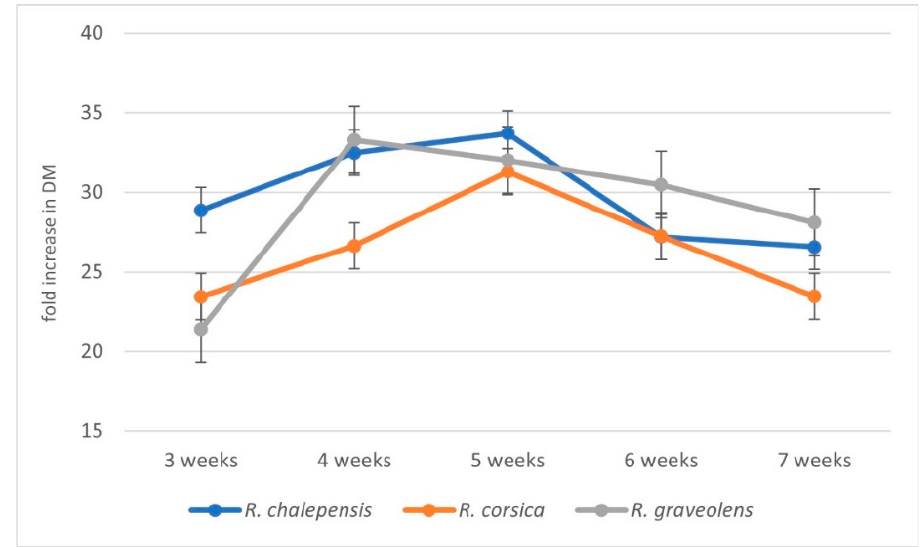
Figure 1. Average ( n = 3, ±SD) biomass increments during the cultivation cycle (3, 4, 5, 6, and 7 weeks) of individual rue species.